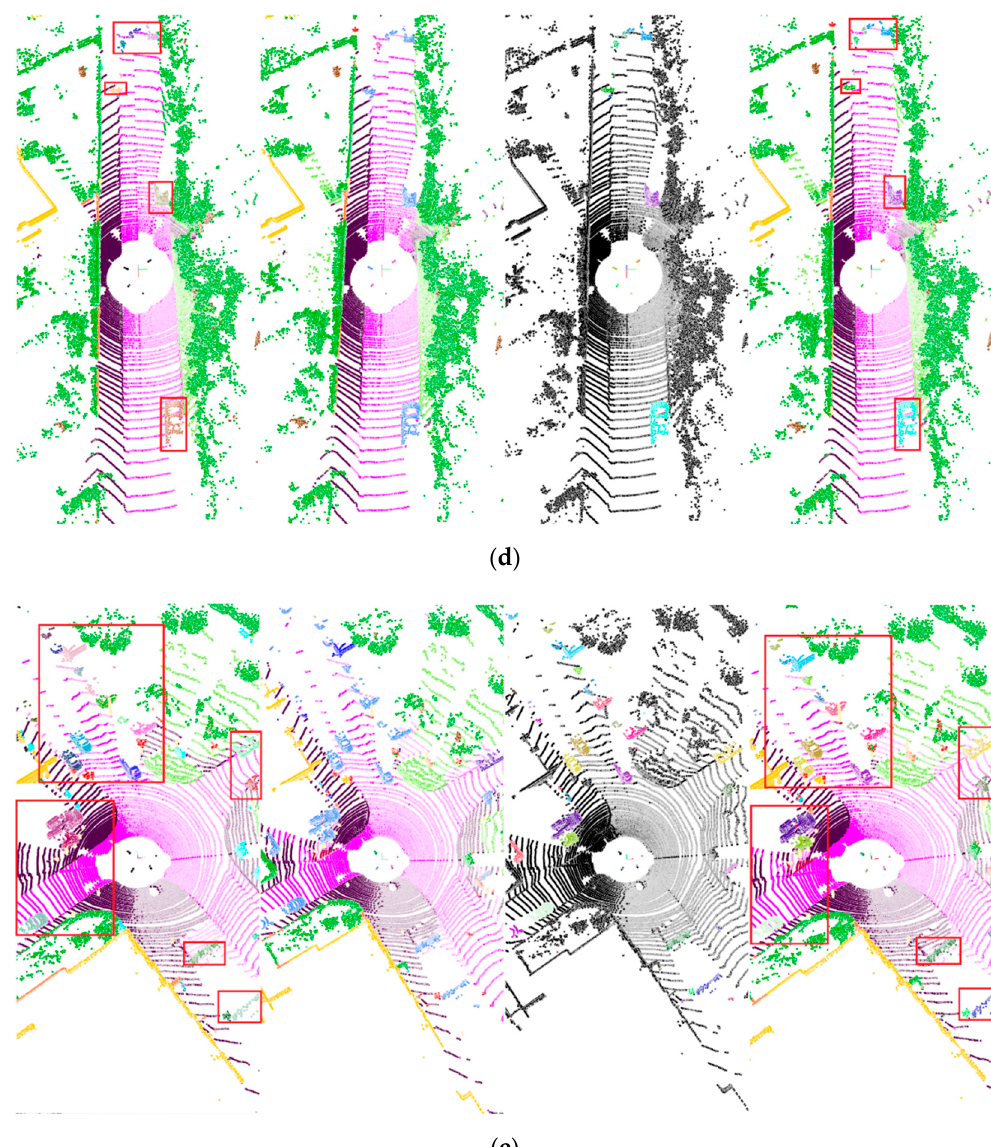
Figure 8. Visualization of our approach on the validation split of SemanticKITTI—sequence 08. To better distinguish instances, we used red rectangular boxes for identification. From left to right: panoptic ground truth, semantic prediction, instance prediction, panoptic prediction. The colors of the stuff classes are consistent with the legends shown in Figure 1e, and the color of each instance of the thing classes in each subfigure is given randomly. ( a ) Scan 800. ( b ) Scan 1600. ( c ) Scan 2400. ( d ) Scan 3200. ( e ) Scan 4000.